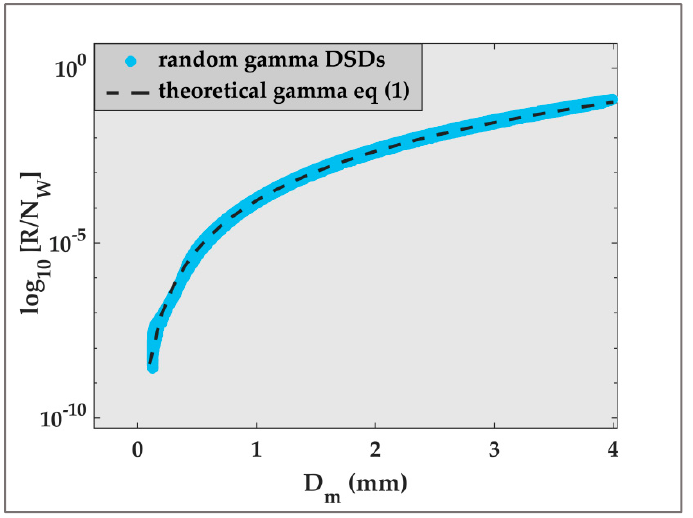
Figure 7. Rain rate (in mm h − 1 ) normalized by N W (in mm − 1 m − 3 ) versus D m (in mm). We compare random gamma DSDs with the theoretical result in Equation (1) with μ = 0.